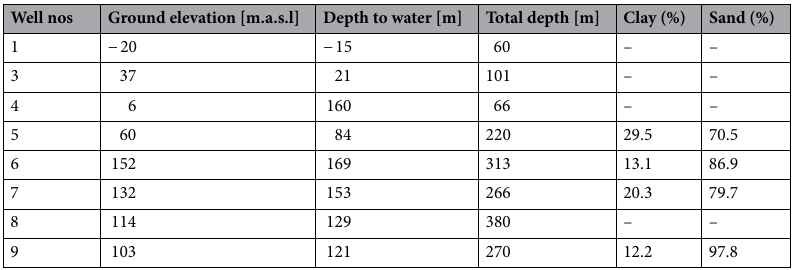
Table 2. Lithologic log analysis of some drilled water wells, around Wadi El Natrun Depression, after 28 .